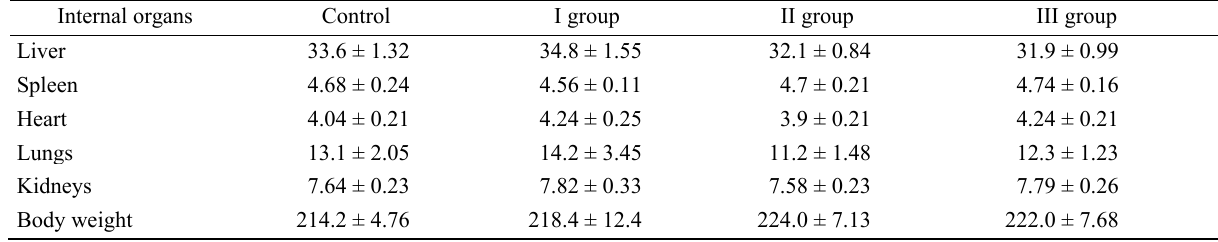
Weight coefficients of the mass of internal organs of white rats for the study of toxicity by the classical method (M ± m, n = 5) Internal organs